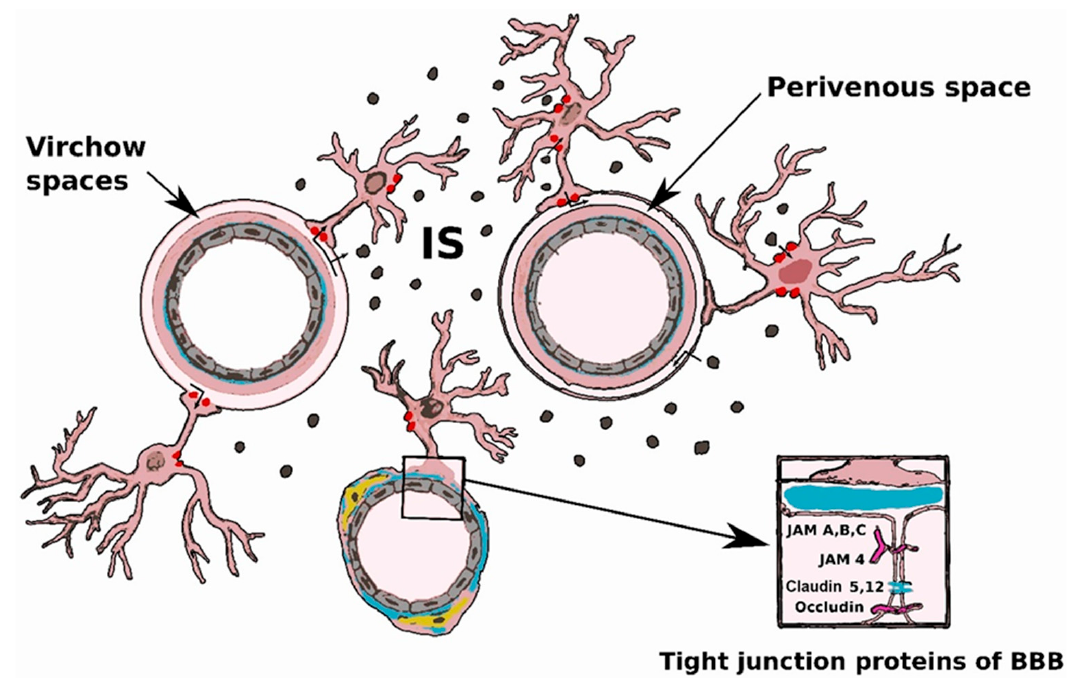
Figure 1. Glymphatic system and blood-brain barrier (BBB). Cerebrospinal fluid (CSF) flows into the brain from subarachnoid and cisternal spaces through periarterial spaces (Virchow spaces). CSF exchanges with interstitial fluid are facilitated by aquaporin-4 (Red dots) located on the end-foot processes of perivascular astrocyte. The CSF motion into the brain pushes the convective streaming of interstitial fluid and interstitial solute (IS) (Black dots) through the extracellular space to perivenous spaces. Perivenous fluid and solutes then drain from the brain mainly along the large-caliber ventral veins. Inset: major proteic components of tight junctions.